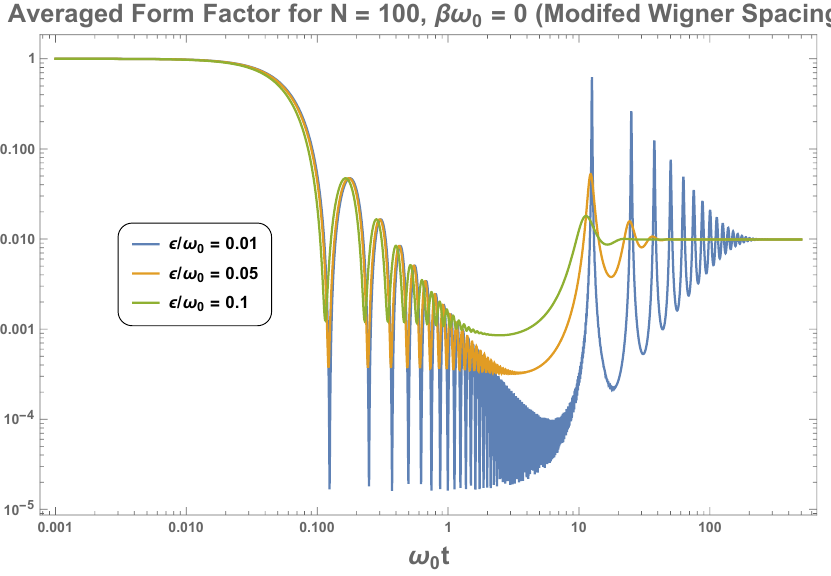
Figure 13 . Above is a plot of the infinite temperature average form factor of a spectrum generated by our i.i.d model ( N = 100 ) with the NNS distribution (modified Wigner surmise) given in eq. (3.28) for various choices of the dimensionless ratio (cid:15)/ω 0